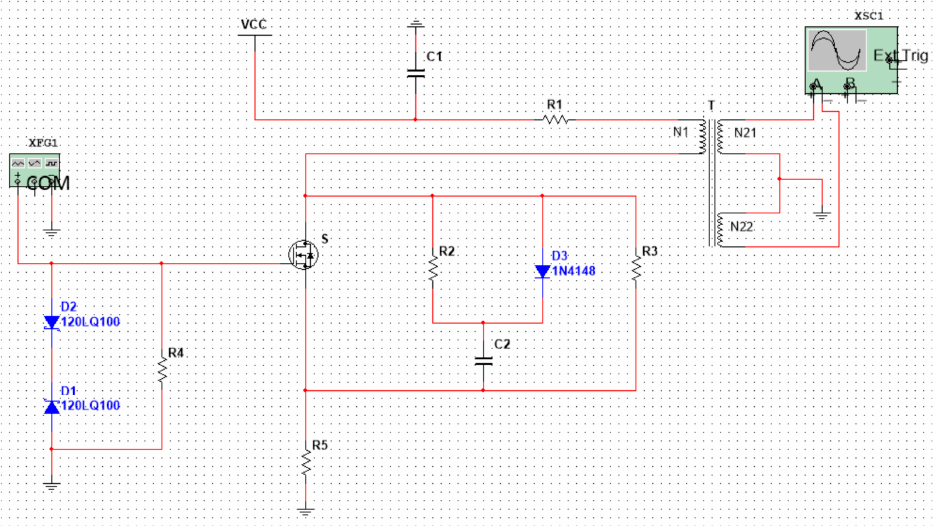
Figure 4. Flyback, high-frequency, high-voltage asymmetric RF electric field.